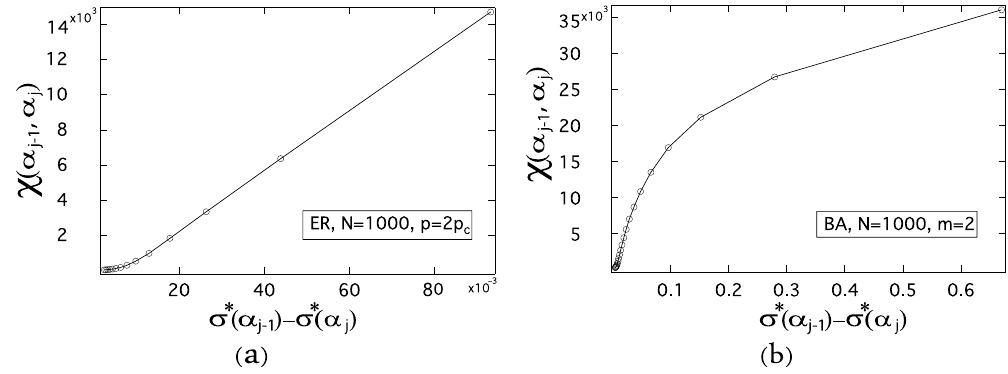
Figure 4. The number χ ( α j − 1 , α j ) of crossings as a function of the difference σ * ( α j − 1 ) − σ * ( α j ) of the normalized standard deviation of the metastable infection probability. For ER graphs, we employ the link density p = 2 p c , thus the average degree E [ D ] = 14, and the size N = 1000 (the NIMFA epidemic threshold (1) ). For BA graphs, we employ the minimum degree m = 2, thus the average degree E [ D ] = 4, and τ ≈ . 0 0673 c (1) τ ≈ . ). The meta-stable infection probability v the size N = 1000 (the NIMFA epidemic threshold 0 0902 k ∞ is c obtained by solving (11), the number χ ( α j − 1 , α j ) of crossings is obtained by (1) and the value of σ * ( α ) is obtained by (7). The results are averaged over 10